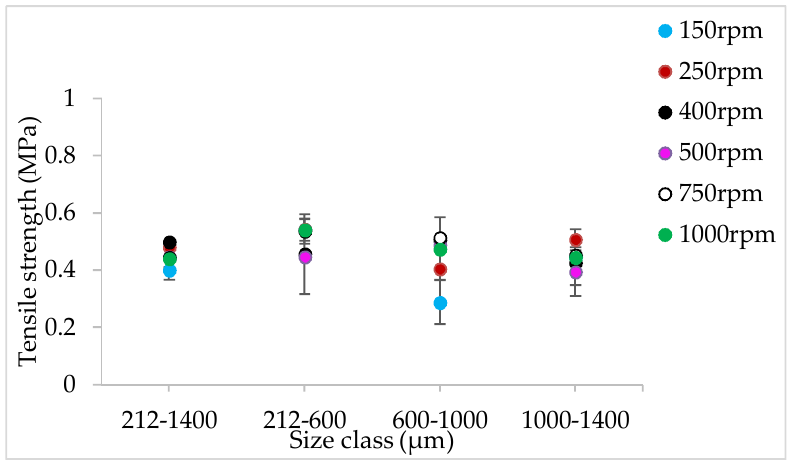
Figure 14. Tensile strength of tablets of lactose granules produced at varying screw speed at SFL—0.166 and PFN—6.85612 × 10 −5 (L/S 0.1).